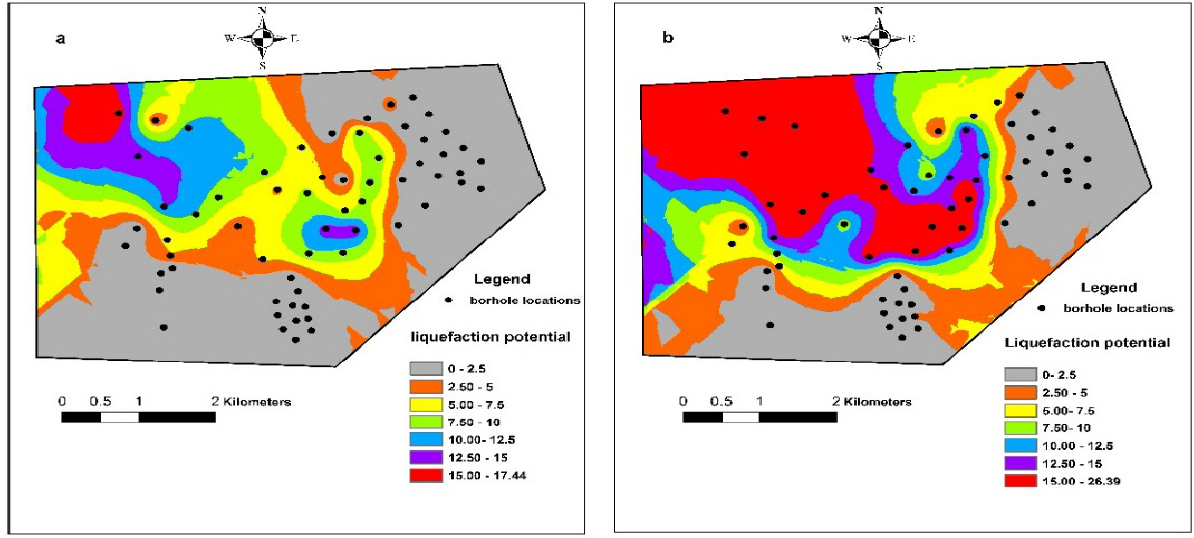
Figure 11: Liquefaction potential hazard map for peak ground acceleration of 0.2 g (a) and 0.25 g (b) (Isotropic